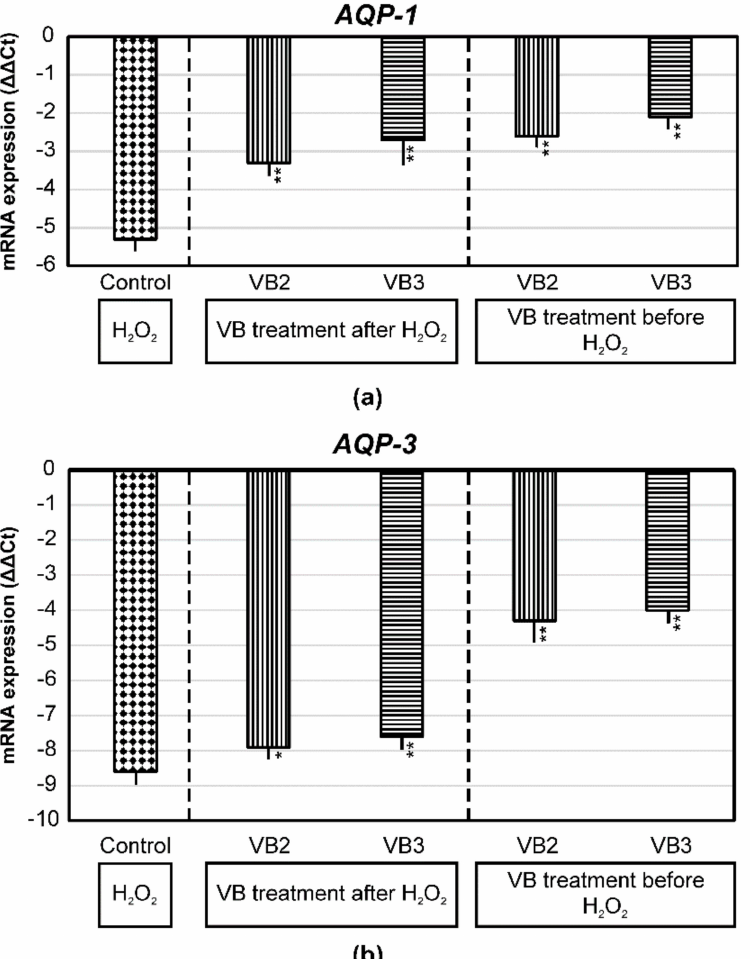
Figure 6. Effects of VBs on the mRNA expression of aquaporins in NHDF treated with H 2 O 2 . To evaluate the therapeutic effects of VBs on oxidative stress, NHDF were treated with 0.2 mM H 2 O 2 for 2 h, washed with PBS, and continued to be cultured with 10 µ g/mL VBs for 4 h. In another experiment, cells were initially treated with 10 µ g/mL VBs for 4 h, washed, and then cultured with 0.2 mM H 2 O 2 for 2 h to monitor prophylactic effects. The mRNA expression levels of aquaporin- 1 (AQP-1) and aquaporin-3 (AQP-3) were measured by qRT-PCR. mRNA expression levels were expressed as ∆∆ Ct. ( a ): AQP-1 mRNA levels, ( b ): AQP-3 mRNA levels. * p < 0.01, ** p <